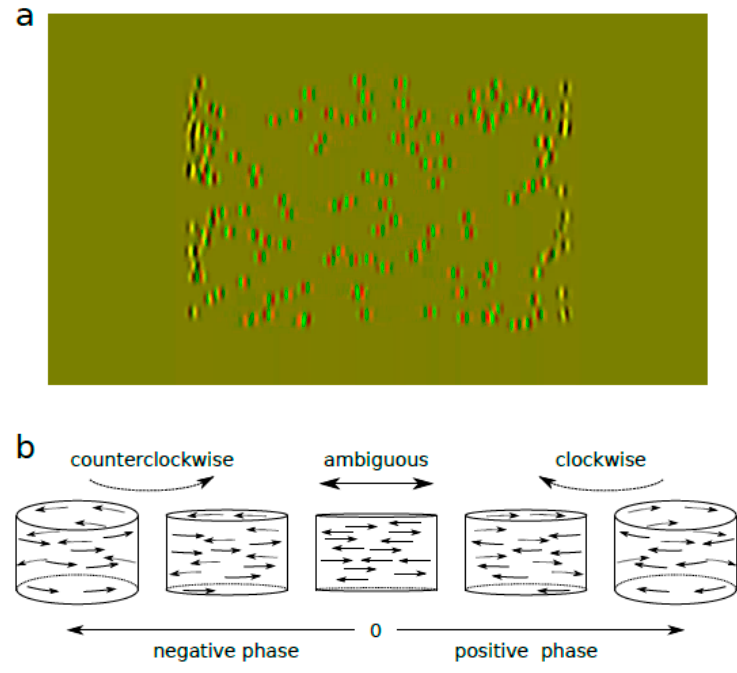
Figure 1. Stimuli. ( a ) Red / green anaglyph representation of the stimulus. It is composed of 200 Gabor patches oscillating horizontally and presented dichoptically. ( b ) The phase di ff erence in the oscillation of the Gabor patches between the two eyes generates a percept of a motion-defined cylinder rotating in depth. If the phase di ff erence is negative, the cylinder is seen rotating anticlockwise. If the phase di ff erence is 0 ◦ , the percept is ambiguous with Gabor patches moving to the left and to the right in the same plane. If it is positive, the cylinder is seen rotating clockwise. Figure adapted from Reference [24].